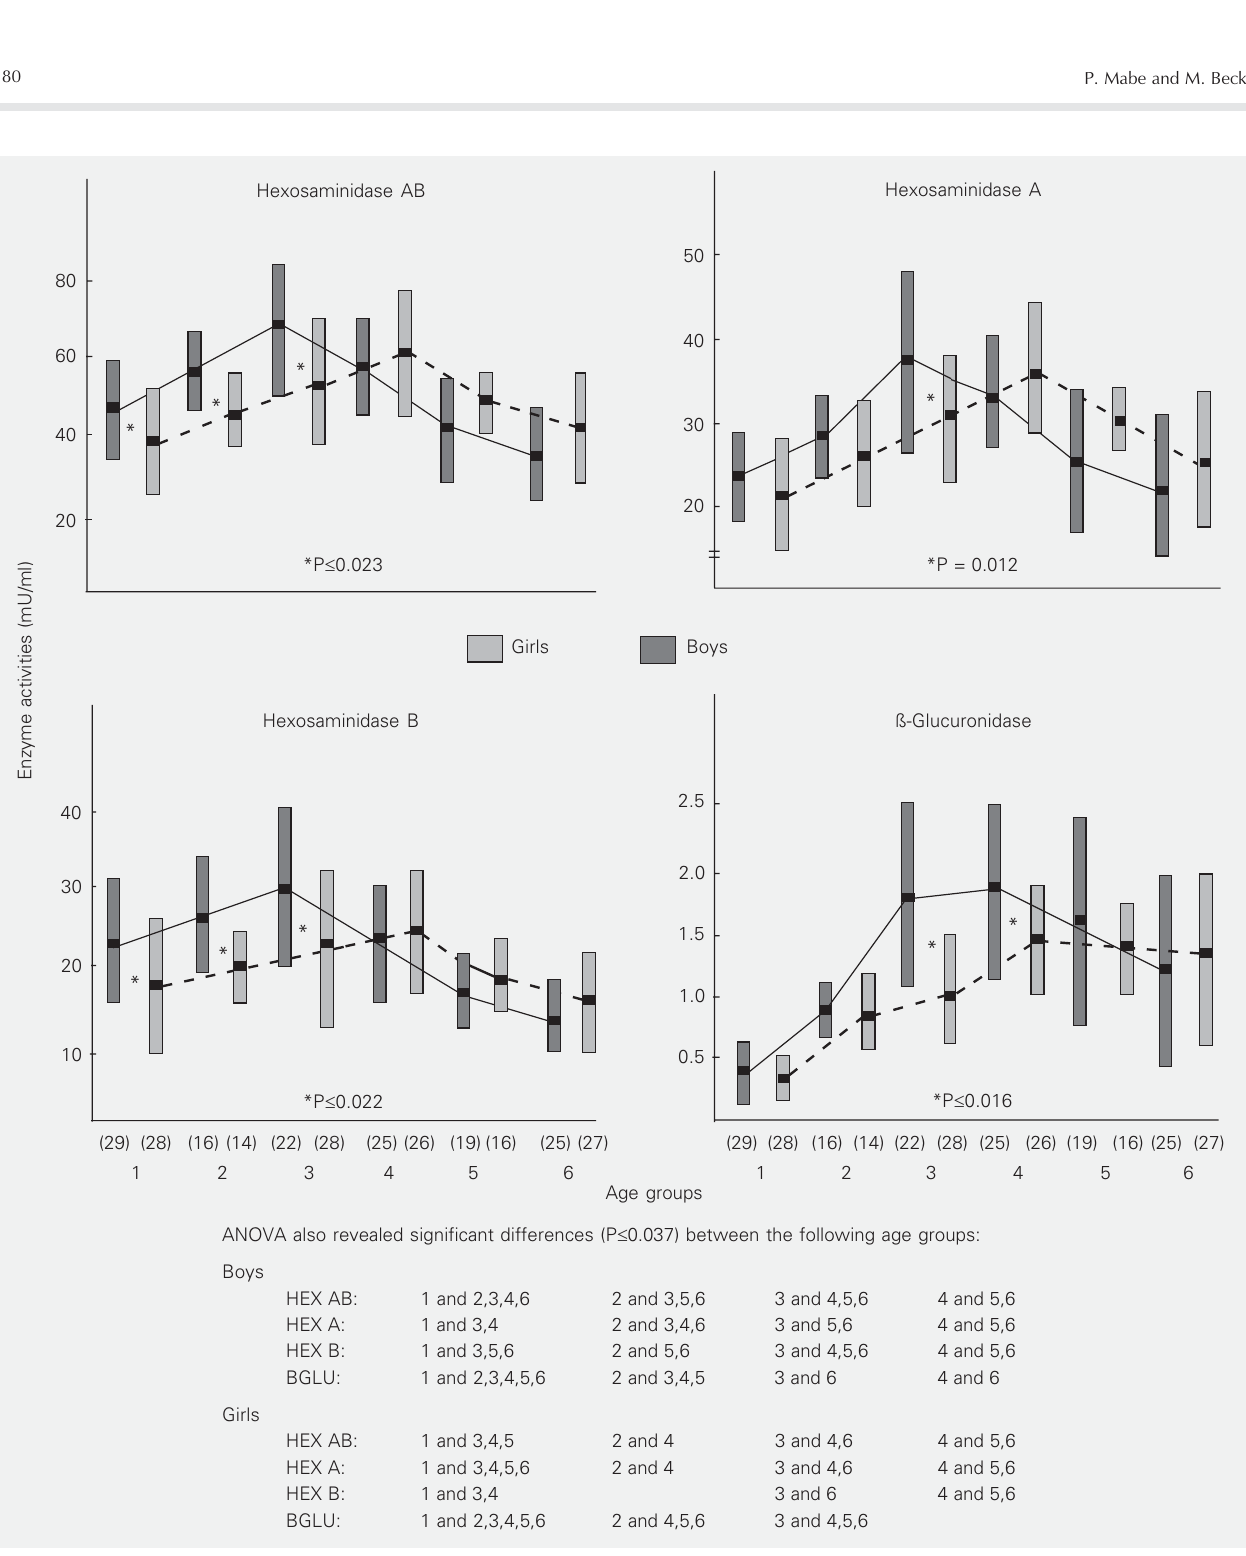
Figure 1. Total serum hexosaminidase (HEX AB), hexosaminidase A (HEX A), hexosaminidase B (HEX B) and ß-glucuronidase (BGLU) activities according to age period and sex. Results are reported as mean ± SD enzyme activities in mU/ml. Numbers in parentheses below the Figure indicate the number of subjects per group. The age groups of 0-3 days, 4-7 days, 2-6 weeks, 7-15 weeks, 16-26 weeks, and 27-53 weeks are represented by the numbers 1, 2, 3, 4, 5 and 6, respectively. Enzyme activities were compared between girls and boys by the Student t -test and between the different age groups according to sex by two-way